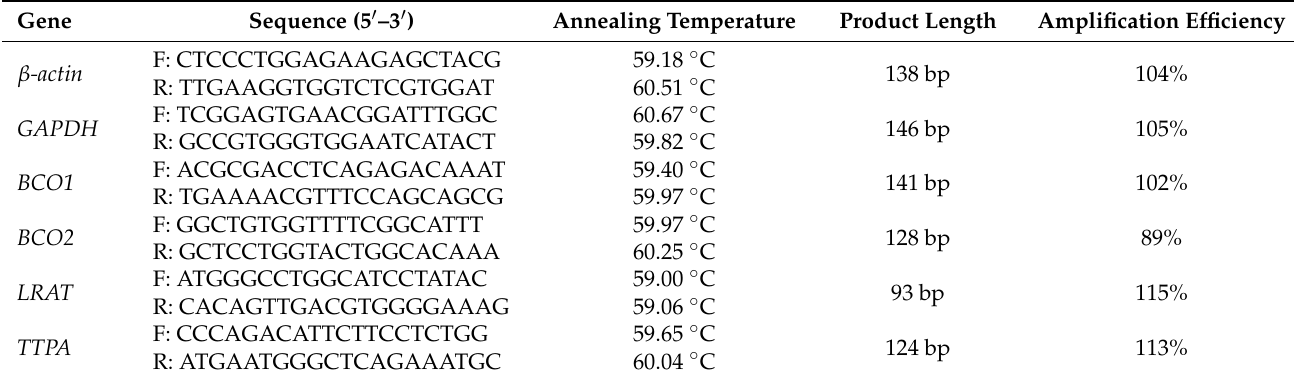
Table 6. RT-qPCR